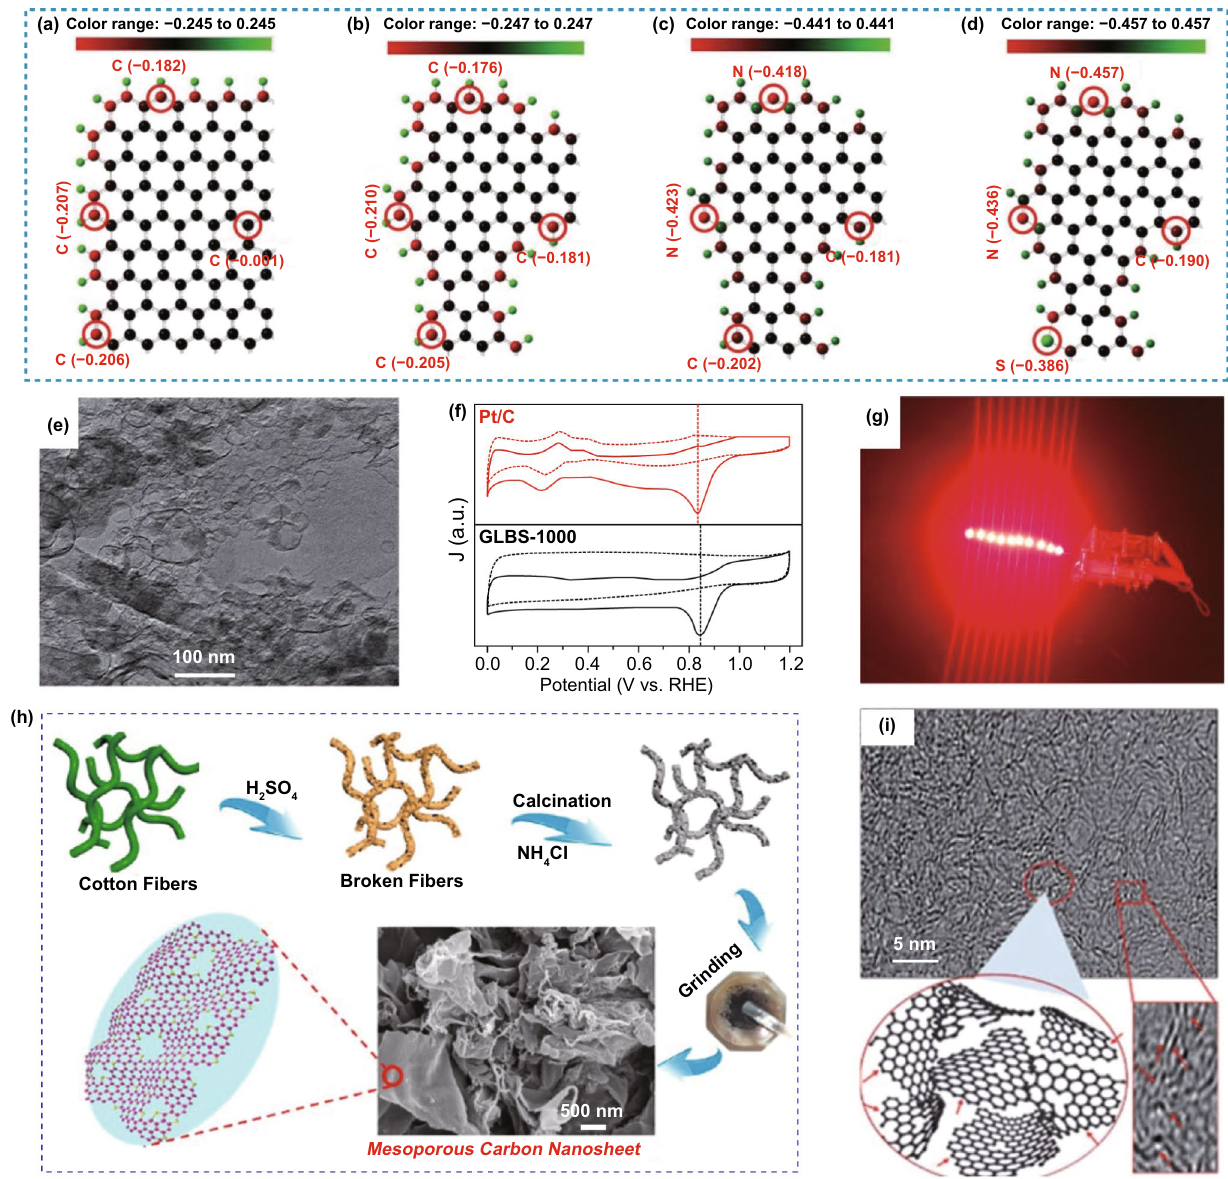
Fig. 8 Defects coupled with multiple dopants in nanocarbon for ORR. a – d Charge density distribution of pristine, defective, N-doped defec- tive and N/S-codoped defective graphene models. Reproduced with permission from Ref. [112] Copyright 2018, Wiley–VCH. e TEM image of GLBS-1000 sample with the hybridized graphene-like nanobubble and nanosheet architectures; f CV curves for GLBS-1000 and Pt/C catalysts. Reproduced with permission from Ref. [102]. Copyright 2016, The Royal Society of Chemistry. g Photograph of 10 parallel red LED lamp beads driven by two Zn–air batteries with the D-S/N-GLC electrode connected in series. Reproduced with permission from Ref. [128]. Copy- right 2017, American Chemical Society. h Schematic of cotton microfiber-derived mesoporous N-doped carbon catalyst. Reproduced with per- mission from Ref. [132] Copyright 2017, American Chemical Society. i TEM image of PC and schematic illustration of the defective structure. Reproduced with permission from Ref. [133]. Copyright 2017, The Royal Society of